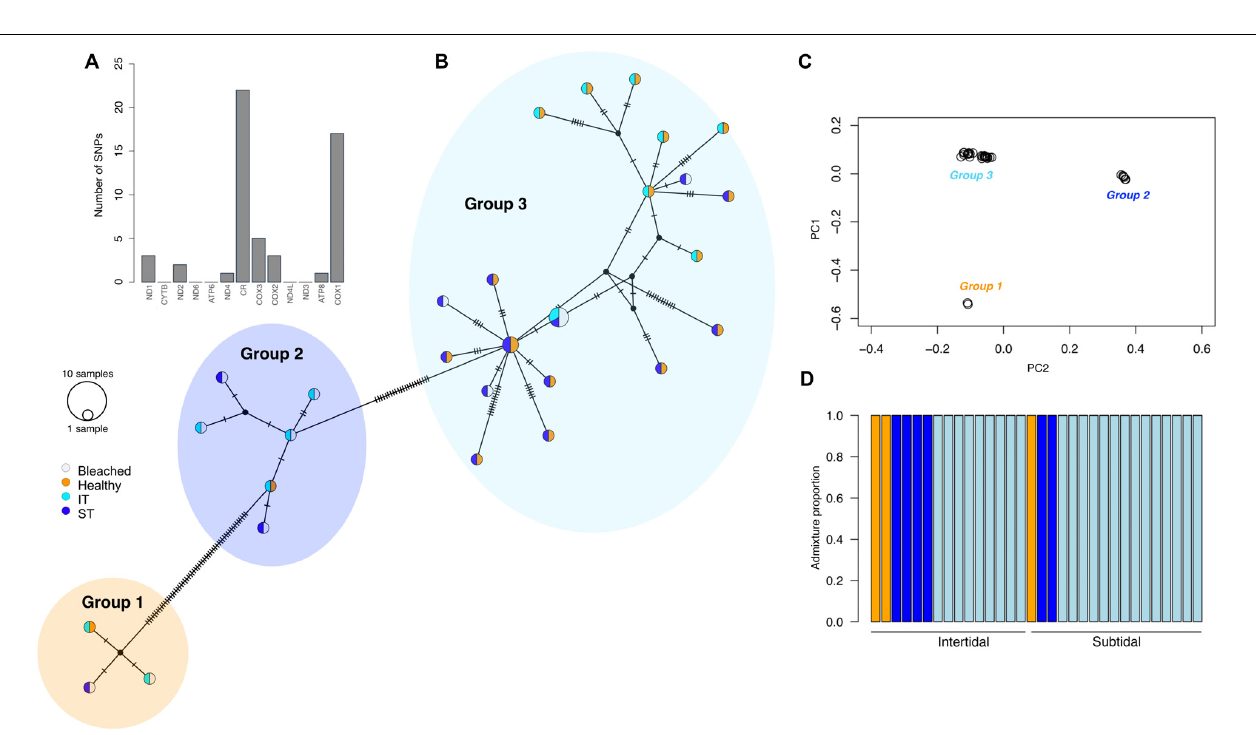
FIGURE 3 | Cryptic genetic diversity in the Acropora aspera species complex on Shell Island, Kimberley. (A) Barplot of number of variant sites found in each gene of the A. aspera mitochondrion; (B) TCS network of the complete mitochondrial genome consensus sequences for each sample; (C) principal components analysis and (D) admixture plot showing the presence of three clear genetic lineages in the colonies (vertical bars) that were tagged during peak bleaching (April 2016).